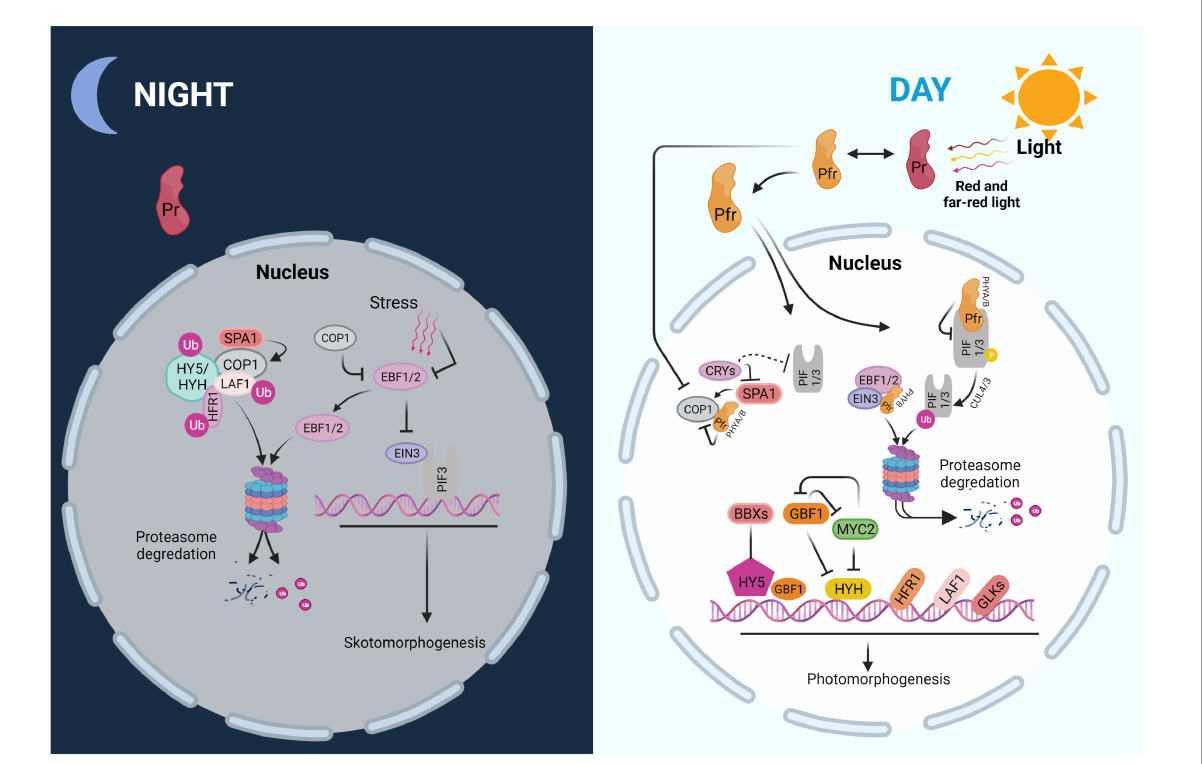
FIGURE2 Scheme of major regulatory networks in skoto- and photomorphogenesis. PIF-EIN3 increases skotomorphogenesis and suppresses chloroplast biogenesis in the dark, when combined with soil-induced mechanical stress. COP1, an E3 ubiquitin ligase, degrades EBF1/2, which impedes EIN3 function. Moreover, COP1 degrades numerous light-responsive transcription factors including HY5, HYH, HFR1, and LAF1 via the ubiquitin-26S proteasome system. Photoactivated PHYs in the Pfr form interact with PIFs upon the onset of light, causing their phosphorylation, ubiquitination, and destruction. PHYB may increase EBF1/2-EIN3 interaction, resulting in EIN3 destruction by the 26S proteasome system. PHYs and CRYs deactivate COP1 at the same time, preventing the degradation of positive regulators including HY5, HYH, HFR1, and LAF1. Furthermore, GBF1 and BBX proteins, as well as other regulators such as GLKs, may interact with HY5 to enhance photomorphogenic